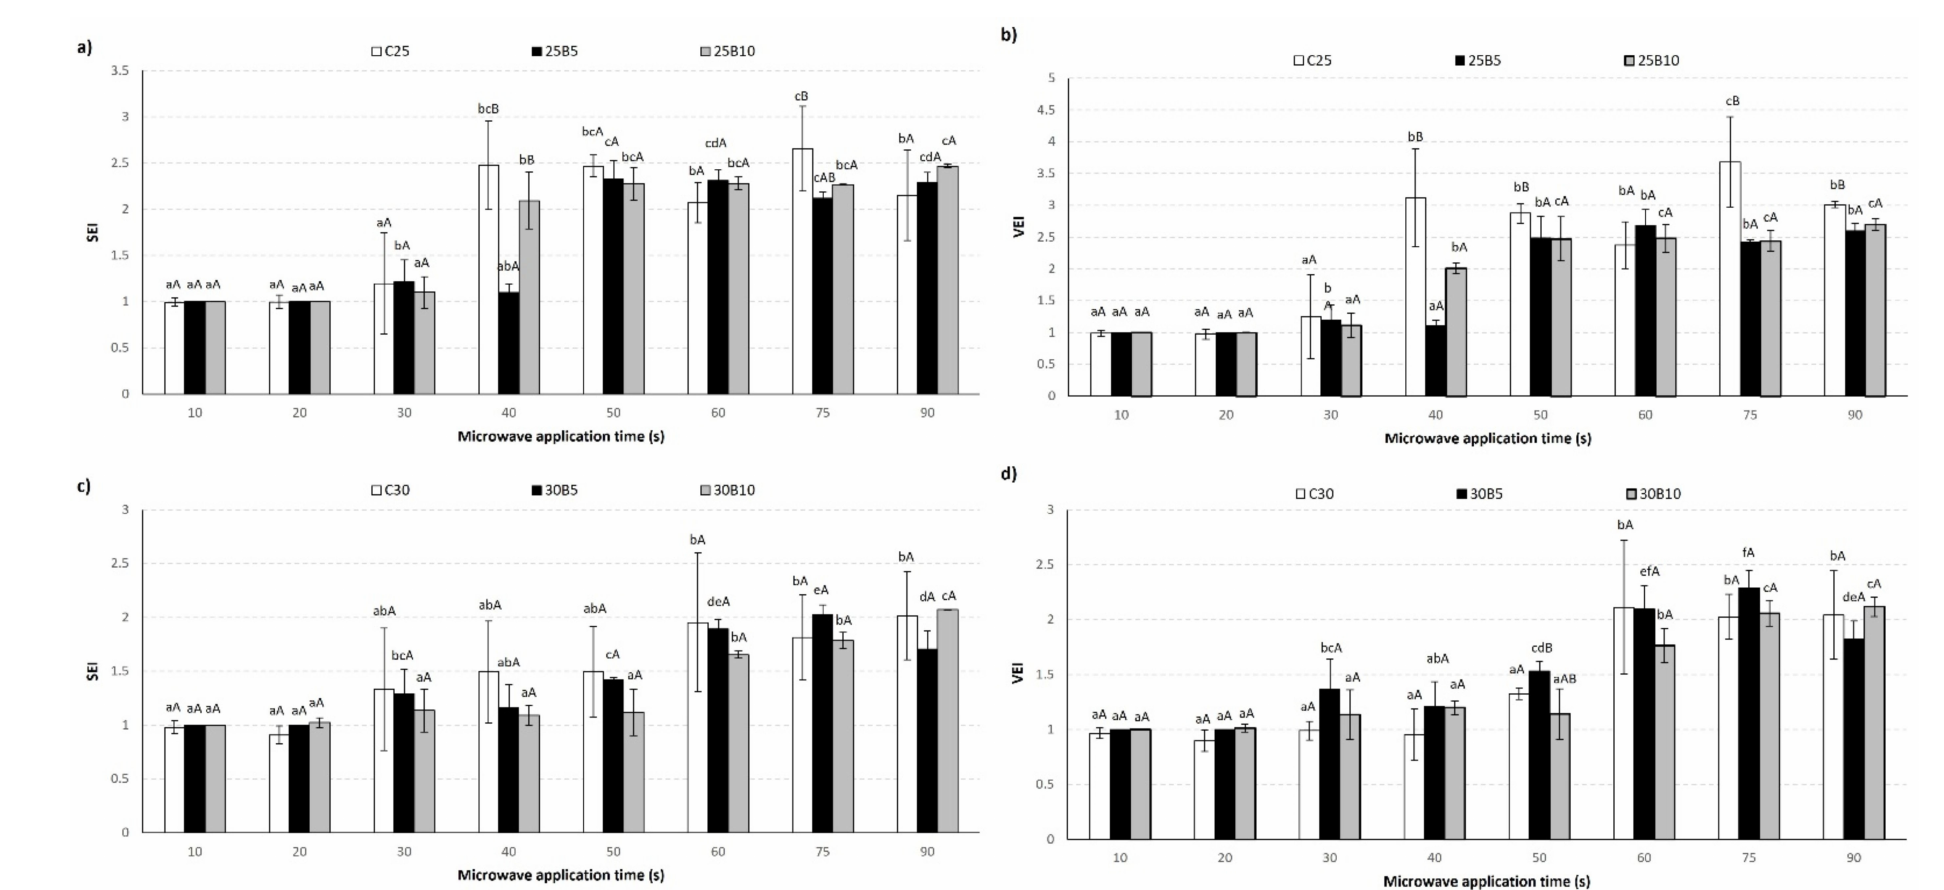
Figure 3. Evolution of SEI ( a , c ) and VEI ( b , d ) of the pellets as a function of the processing time for studied samples (C25: Control snack with 25% water content in mixture, C30: Control snack with 30% water content in mixture; C25B5: Snack with 25% water content and 5% beetroot content in mixture, C25B10: Snack with 25% water content and 10% beetroot content in mixture, C30B5: Snack with 30% water content and 5% beetroot content in mixture, and C30B10: Snack with 30% water content and 10% beetroot content in mixture). Different letters on the bars a, b, c, d, e, f represent significant differences ( p < 0.05) by microwave expanded application time, and A, B represent significant differences ( p < 0.05) by water